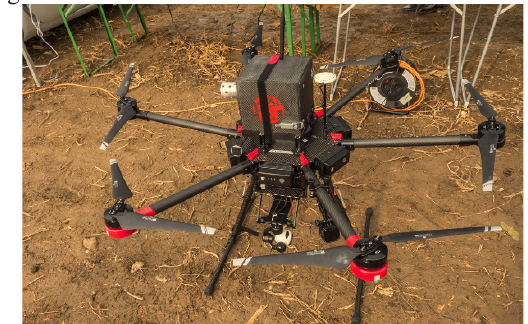
TABLE I. M AIN PARAMETERS OF THE RMS-000 MODULE [3]